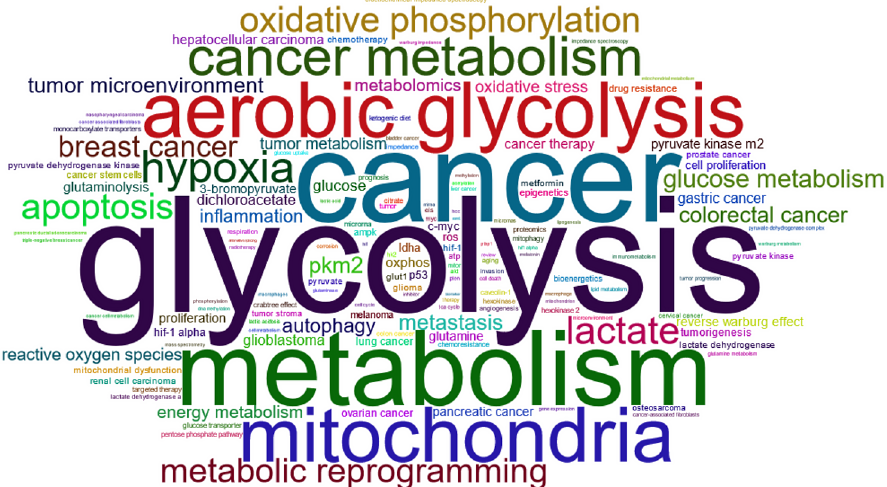
Figure 4. Cloud of keywords provided by the authors of articles dealing with the Warburg effect. This cloud was generated with the R package bibliometrix (version 3.2.1) on 3128 documents extracted from the World of Science database for articles between 1969 and 2022 including the term “Warburg effect” in the title, abstract or in